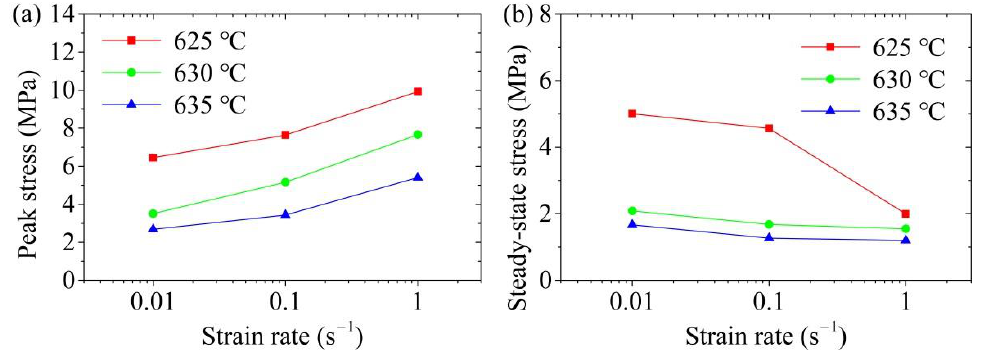
Figure 6. Influence of the strain rate in SSIC on the ( a ) peak stress; and ( b ) steady-state